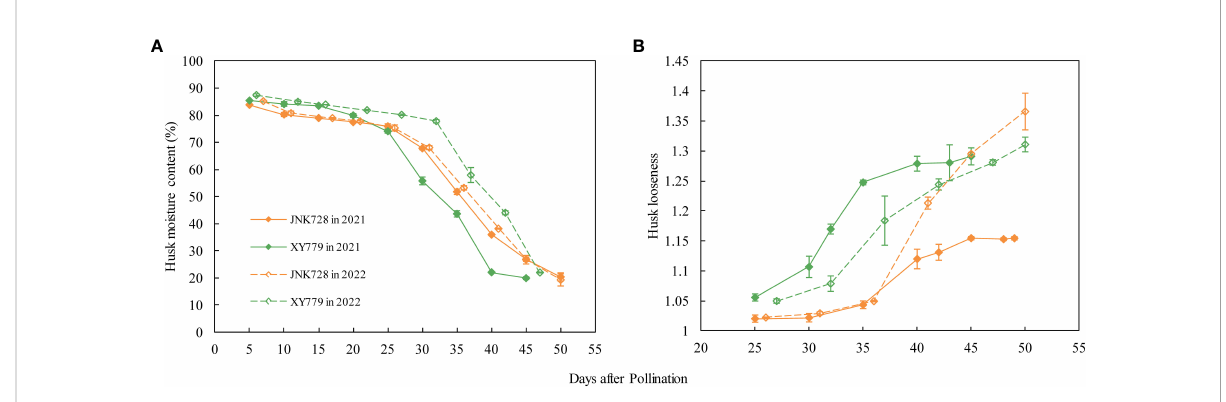
FIGURE 12 (A) Husk moisture content and (B) husk looseness of JNK728 and XY779 at grain fi lling stage in 2021 and 2022. The values are presented as means ± SE( n